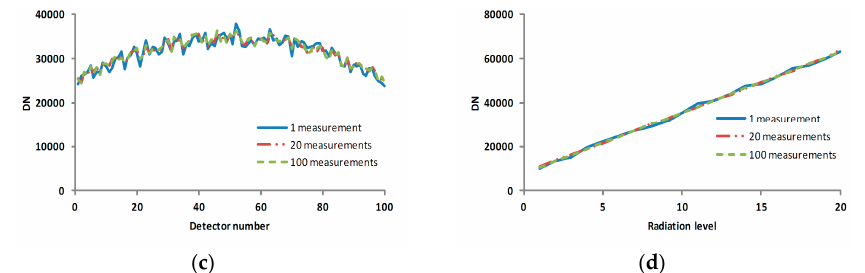
Figure 4. The measurement data profile with the multiplicative factor, the additive factor and various numbers of measurements. ( a ) the curve of multiplicative factors of pixels; ( b ) the curve of additive factors of pixels; ( c ) the profile of line 10 in Figure 3; and ( d ) the profile of column 50 in Figure 3. The horizontal axes of ( a – c ) are the pixel number, and the vertical axes of ( a – c ) are the multiplicative factor, additive factor and DN, respectively. The horizontal axis and vertical axis of ( d ) are the radiation level and DN, respectively.